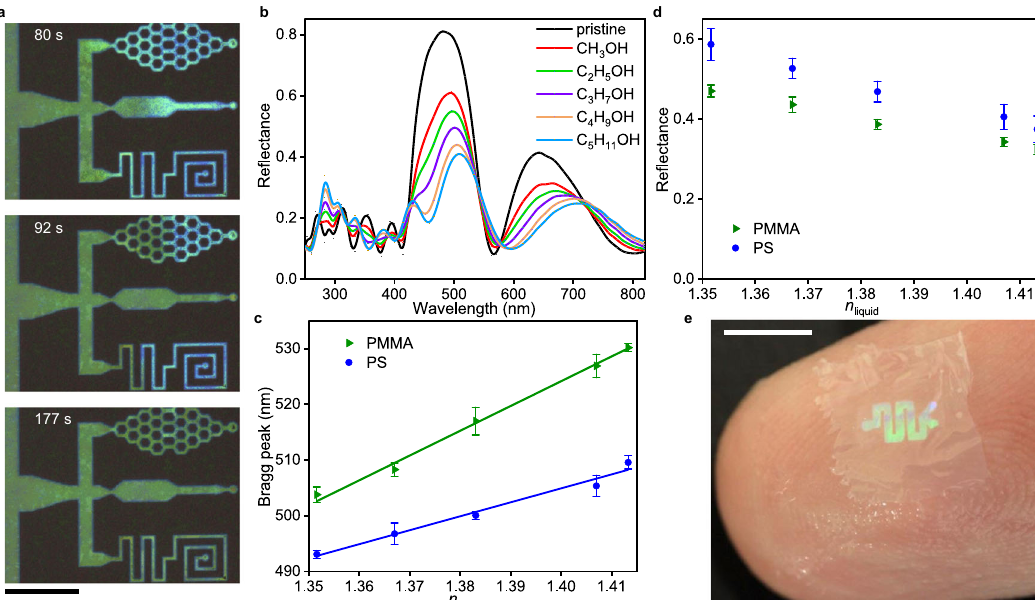
Fig. 4 In situ sensing by OM micro fl uidics. a Colour change observed by optical microscope as liquid ( n -hexadecane) fl owing through OM microchannels. The photos are extracted from Supplementary Movie 1. b Re fl ectance spectrum for different alcohols fl owing in OM channels. c Bragg peak location and ( d ) peak re fl ectance versus the refractive index of the in fl ow liquid. e A macro lens photo showing an OM micro fl uidics sticking on human fi nger. Scale bar,